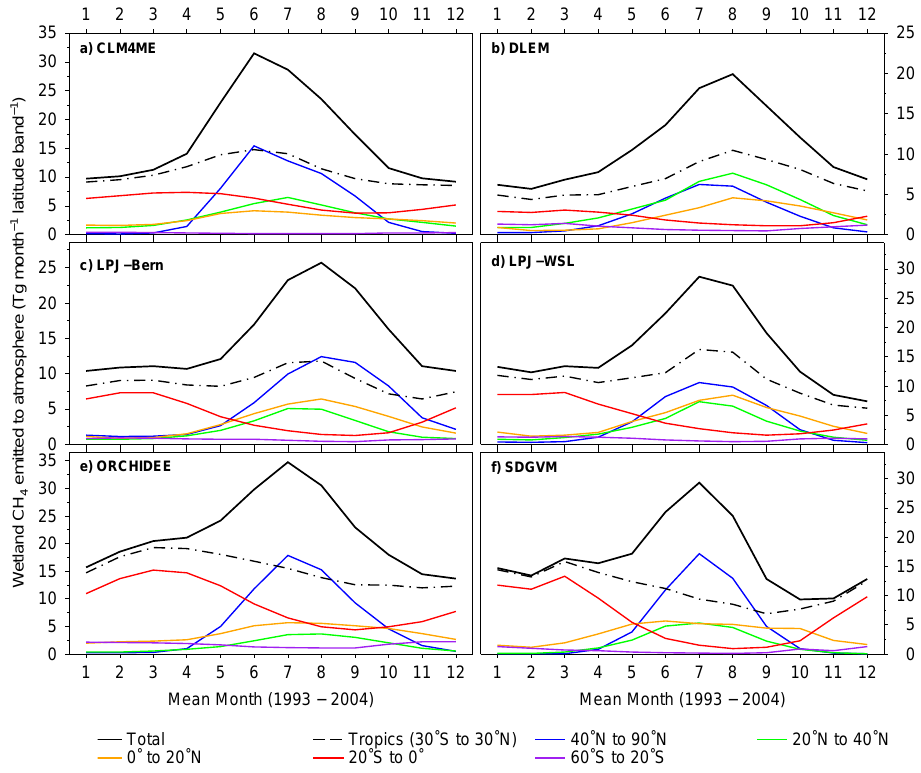
Fig. 6. Mean monthly simulated methane emissions by latitudinal band for 1993–2004 for all models with monthly emissions and global extent. Note the magnitude of the y-axes differs between